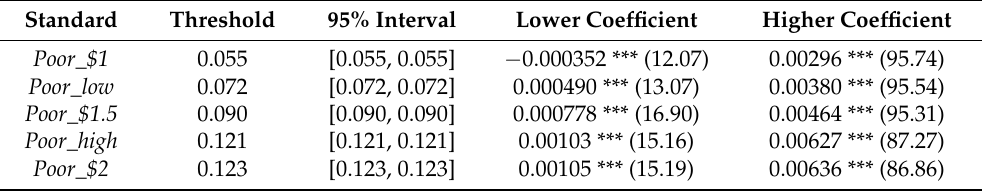
Table 23. Threshold estimates, confidence intervals, and coefficient changes.